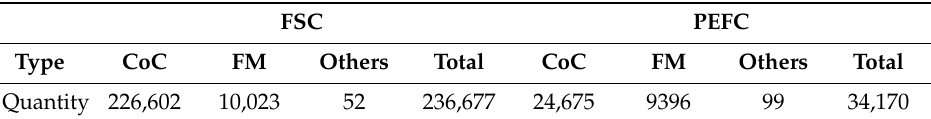
Table 1. Quantity of the Forest Stewardship Council (FSC) and Program for the Endorsement of Forest Certification Schemes (PEFC) certifications.